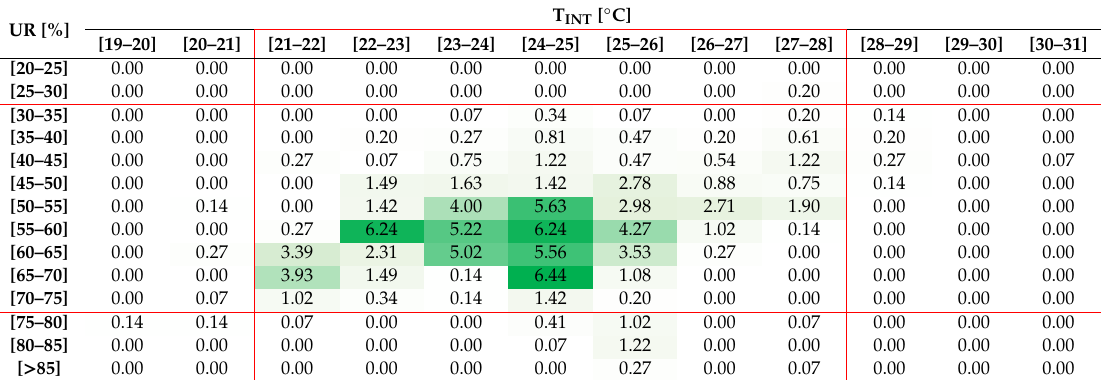
Table 7. Percentage distribution of the sample of data available for the development of the